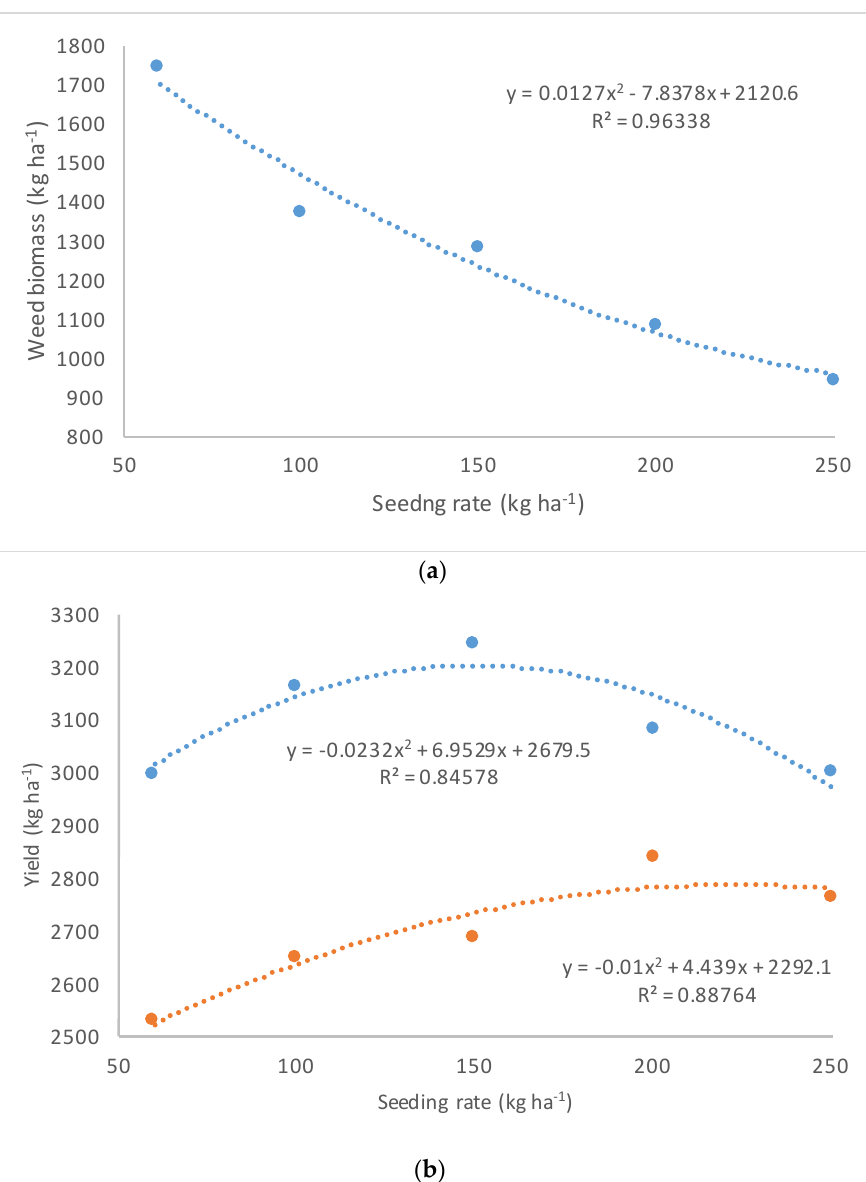
Figure 2. ( a ) Effect of seeding rate on weed biomass. ( b ) Effect of seeding rate on rice paddy yield Figure 2. ( a ) E ff ect of seeding rate on weed biomass. ( b ) E ff ect of seeding rate on rice paddy yield under conditions of weed ‐ free (blue) and weedy (red). under conditions of weed-free (blue) and weedy